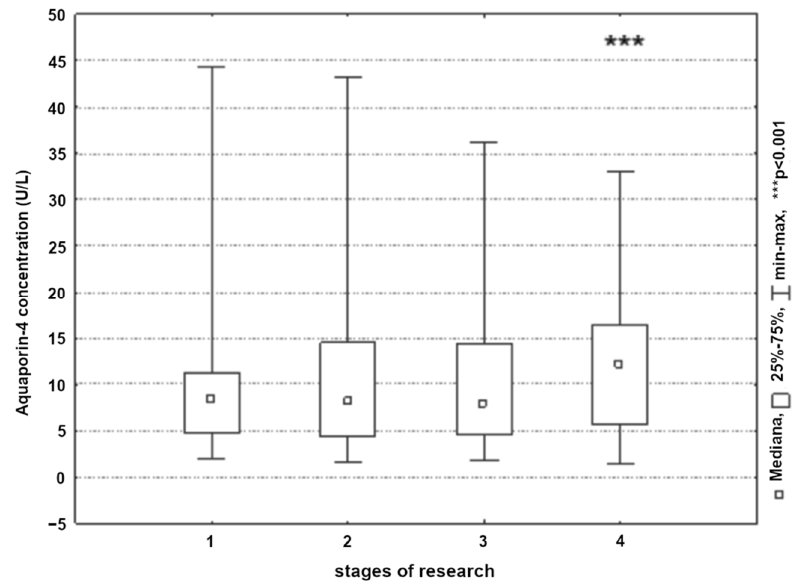
Figure 8. Aquaporin-4 concentration in patients in the next stages of research (1, 24 h before surgery; 2, 8 h post-surgery; 3, 24 h post-surgery; and 4, 48 h post-surgery).